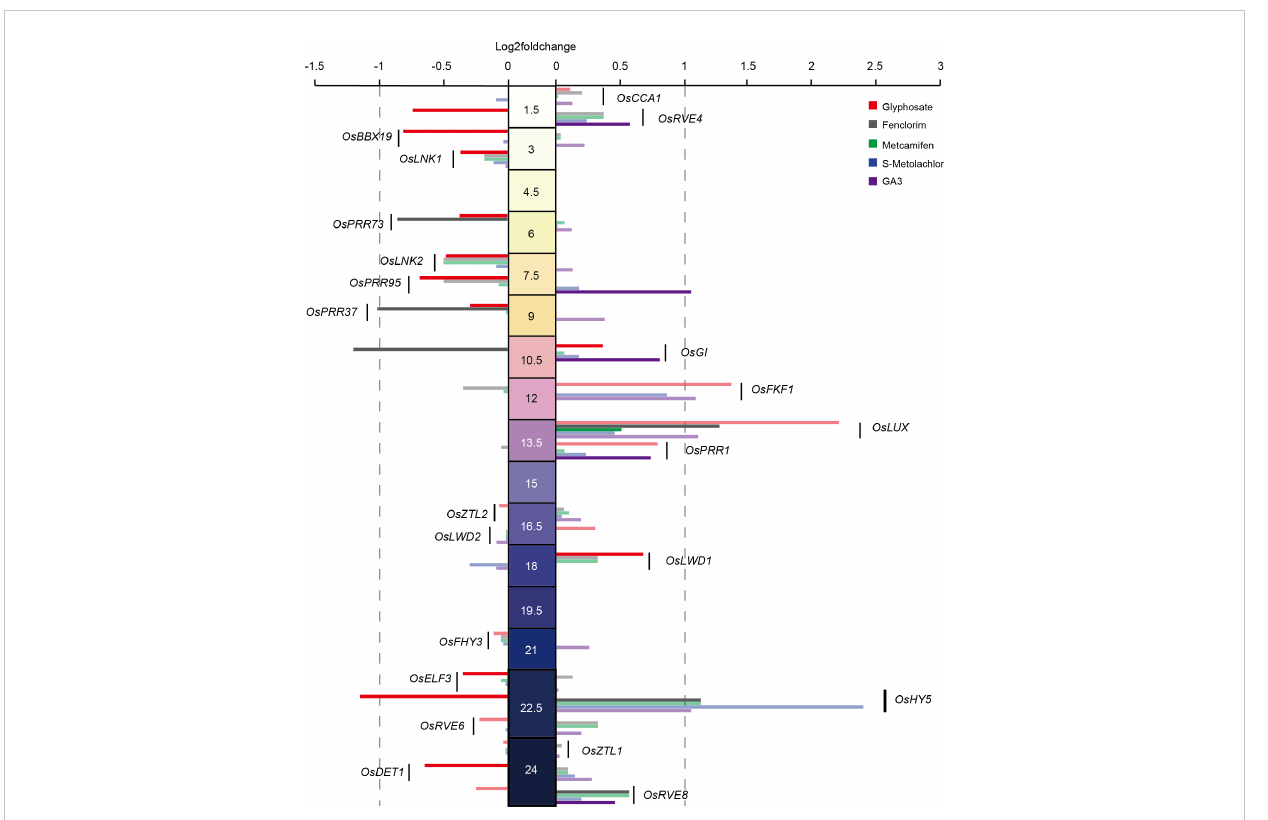
FIGURE 6 Effects of herbicide application on rice central circadian oscillator. The middle values indicate the phase (ZT) of genes. Opaque columns indicate that a signi fi cance level has been achieved